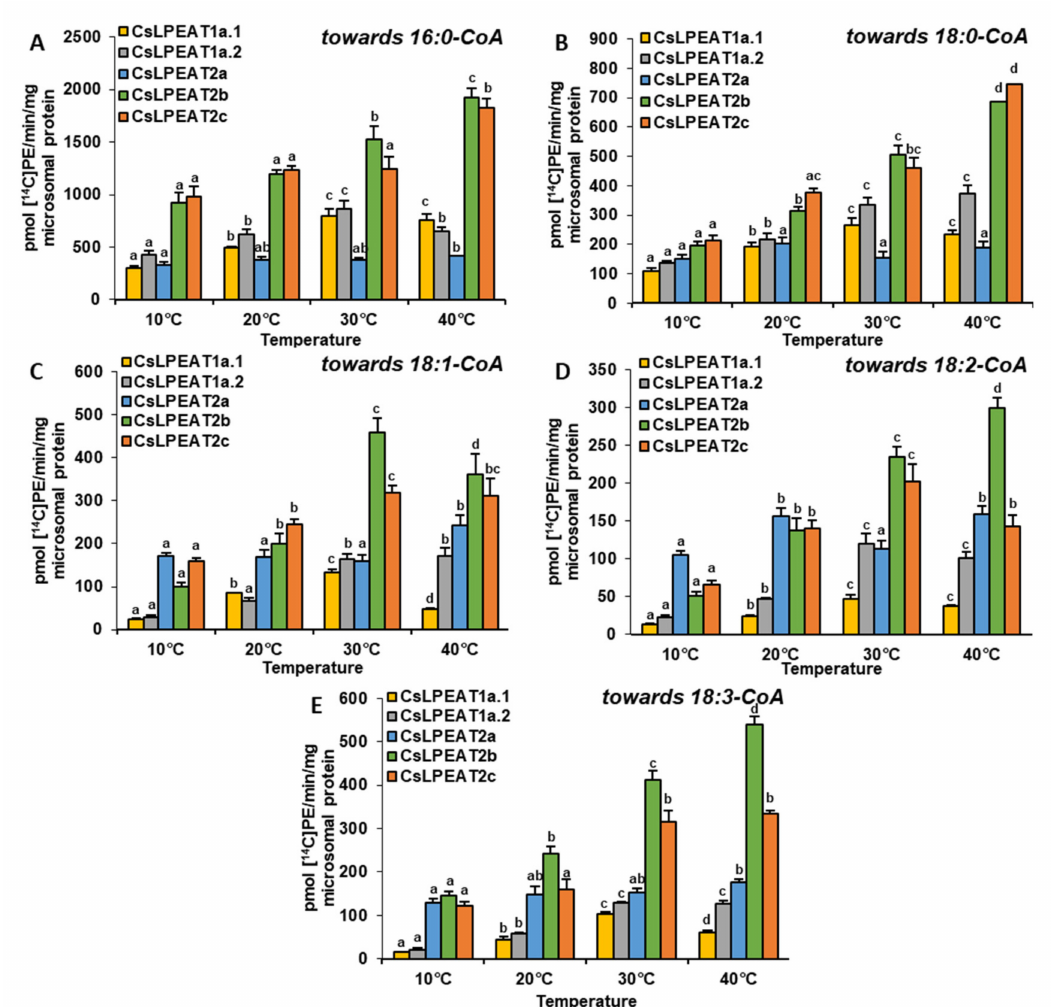
Figure 6. Acyl-CoA specificities of Cs LPEAT isoforms with various acyl-CoA donors and 18:1-LPE as an acyl acceptor, in a yeast system. Each panel corresponds to activity towards a different acyl donor: ( A )—16:0-CoA, ( B )—18:0-CoA, ( C )—18:1- CoA, ( D )—18:2-CoA and ( E )—18:3-CoA. Error bars indicate the SD between at least three repeats ( n ≥ 3). Statistical analysis of the difference in activity of each isoform at various tested temperatures were done by one-way ANOVA followed by Tukeys test. Different letters indicate significant difference ( p ≤